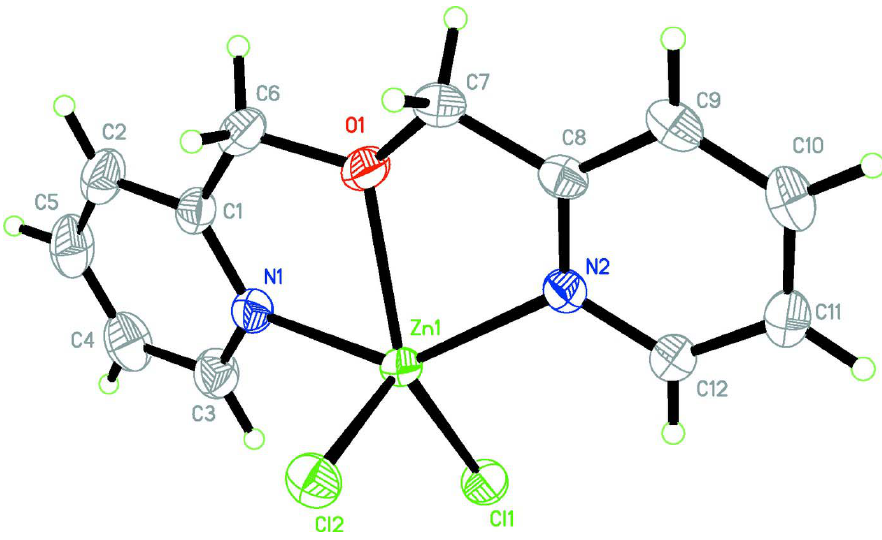
Figure 1 View of complex (I), showing the atom numbering scheme with thermal ellipsoids drawn at the 30% probability level Dichlorido[2,2 ′